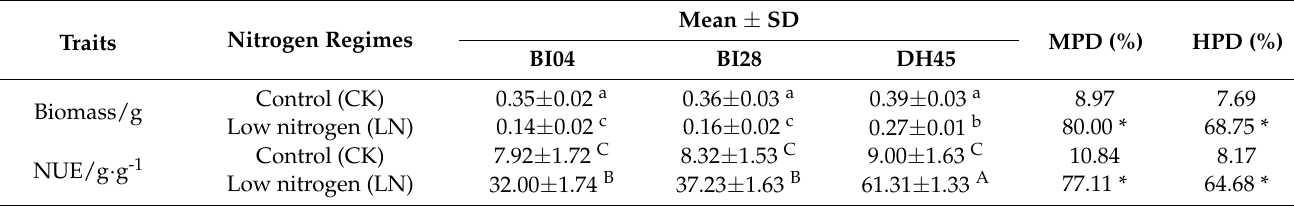
Figure 3. Relative shoot biomass of 7d seedlings of 10 DH lines growing under LN conditions in hydroponics. The green and yellow columns represent the value of BI04 and BI28, respectively. The red lines indicate the value for a better parental line and the maximum value for a “better” parent was also presented. The arrows indicate the performance of DH45. The relative shoot biomass was calculated as shoot biomass under the low-nitrogen (LN) condition/shoot biomass under the control condition (CK). The arrows indicate the performance of DH45. All data represent three biological replicates. Table 3. Comparison of shoot biomass and NUE between DH45 and parents at seedling growth stage (Zadoks growth scale 19) in hydroponic